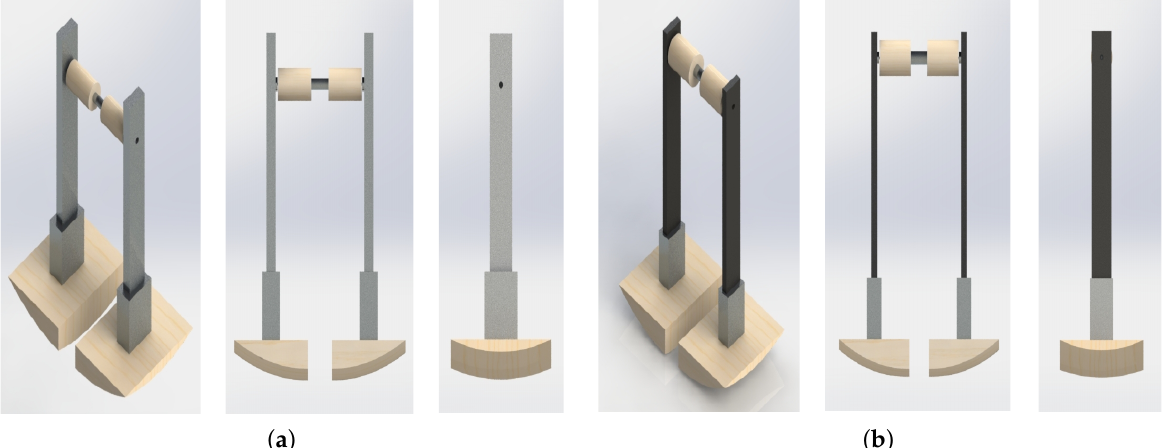
Figure 9. CAD representation of the SPBR: ( a ) S-C design. ( b ) Sequential